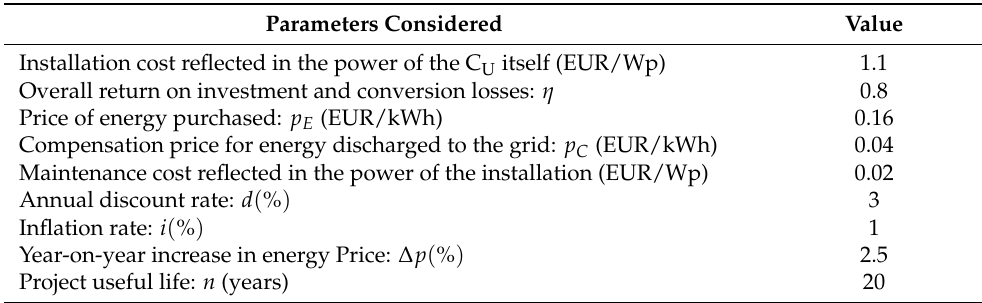
Figure 5. Hourly profiles of demand in: ( a ) January and ( b ) July [36]. Table 3. Parameters considered for the economic analysis of PV installations with